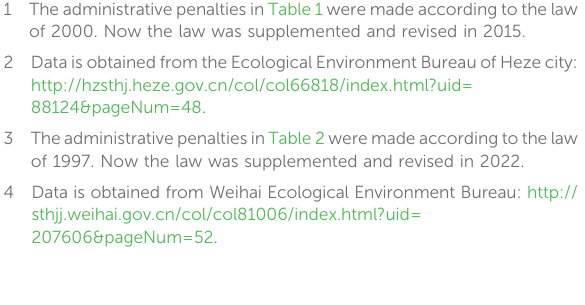
Table 2. Article 56 of Law of the People ’ s Republic of China on